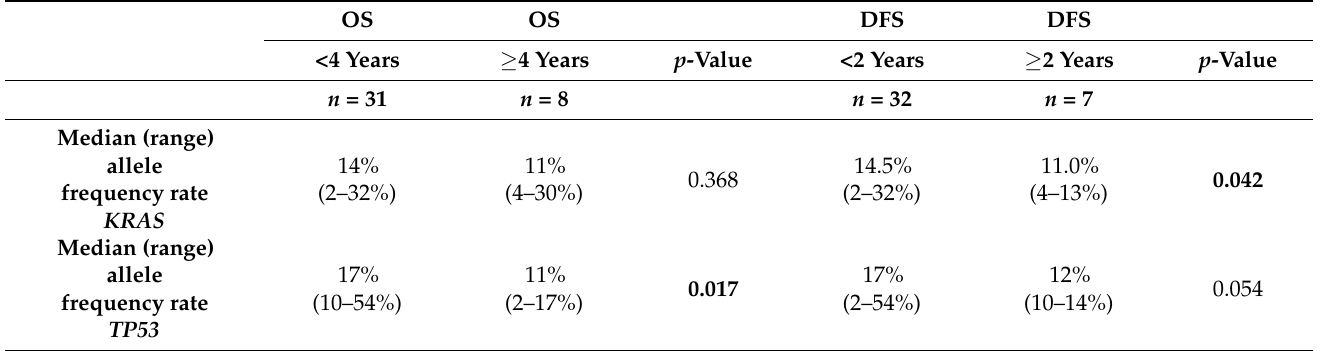
Table 4. Correlation analysis between survivor subgroups and median allele frequency rates of pathogenic KRAS and TP53 mutations. A Mann–Whitney U test was used to test for significance ( p -value < 0.05 indicates